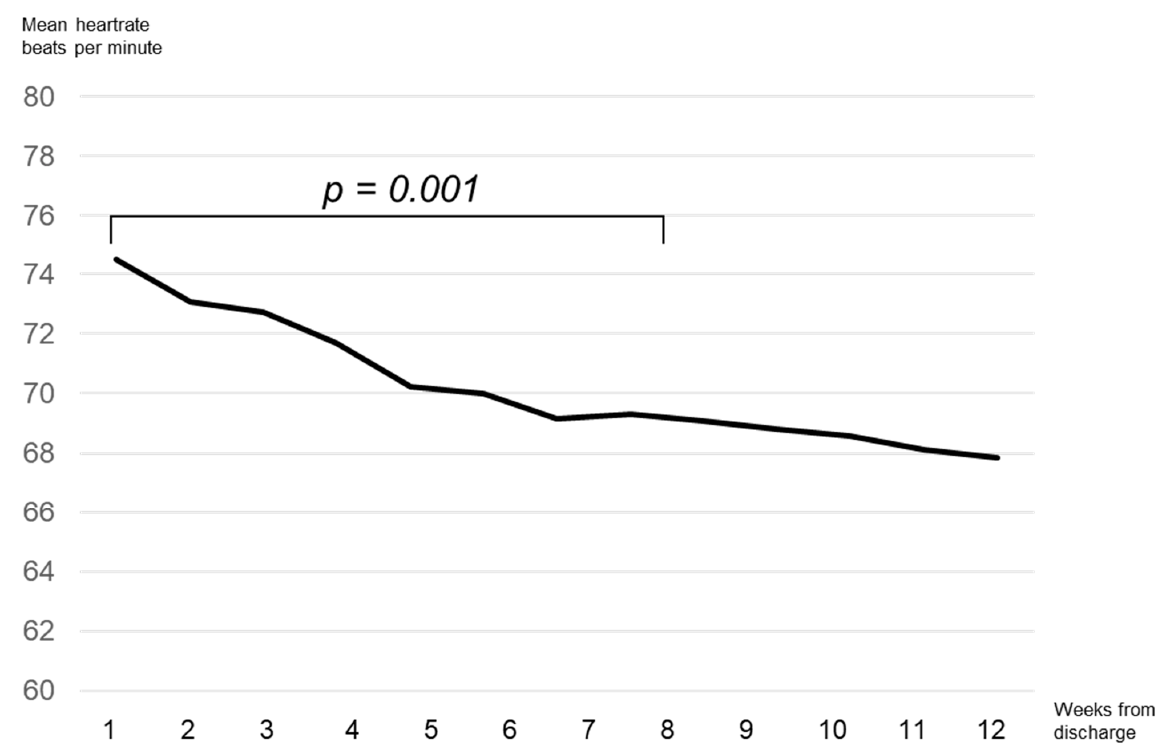
Figure 2. Mean heart rate after discharge.